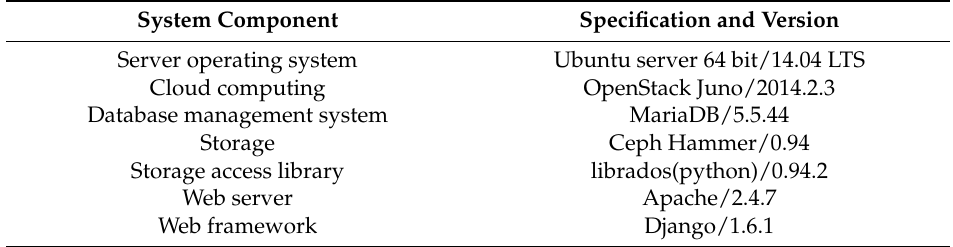
Table 1. System specifications for the auto-scaling experiment.